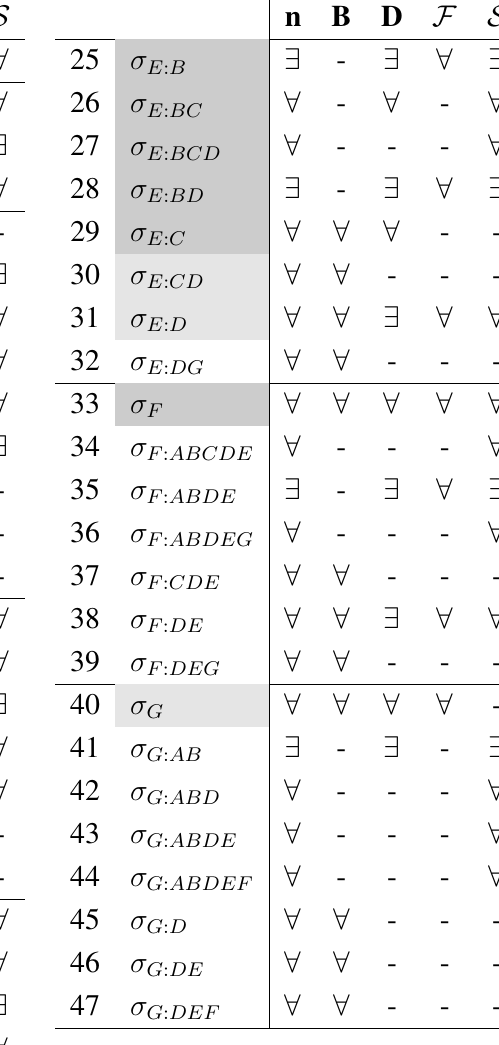
Table 2. In white: placement in home-states, in dark gray: placement that only affect resources in error operation, and in gray: placement in home-states that only affect resources in error operation.